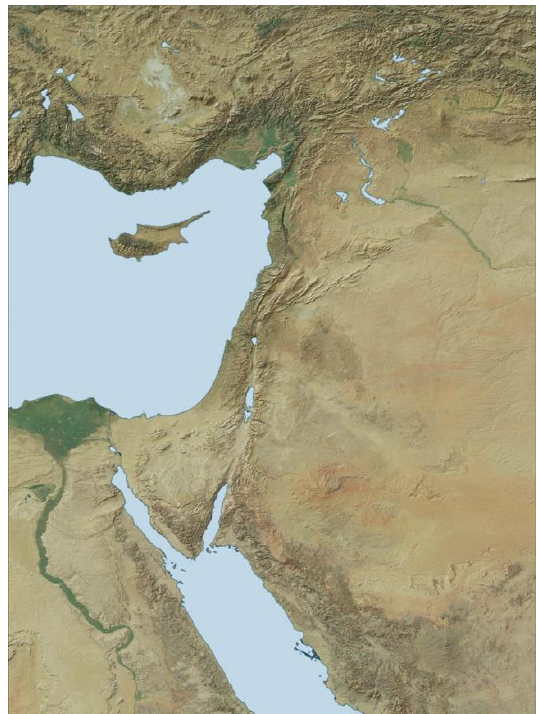
Figure 10. MODIS image merged with SRTM-30 DEM. Here at scale approx. 1: 10 000 000